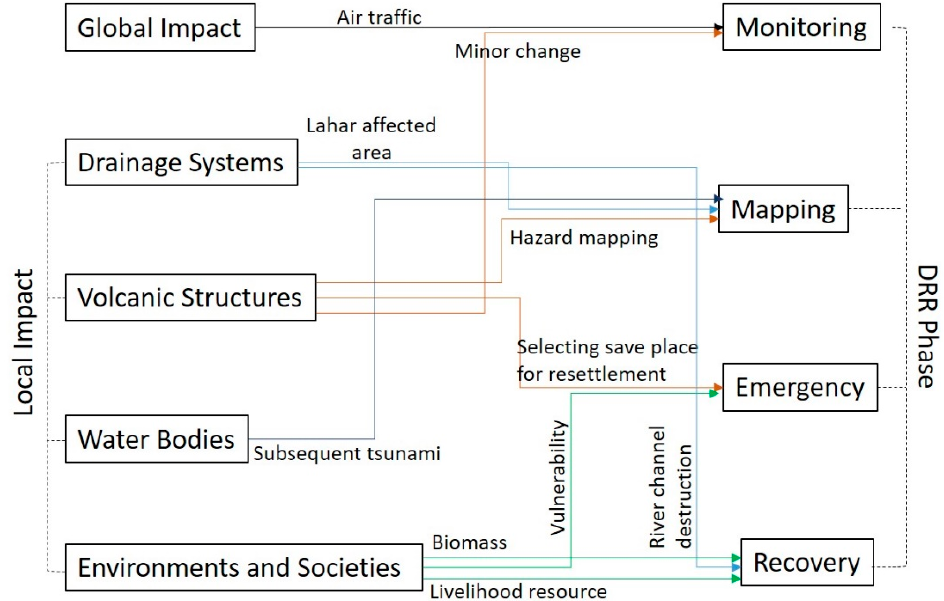
Figure 7. The relation between the impacts of volcanic eruption and disaster risk reduction pro- grams.